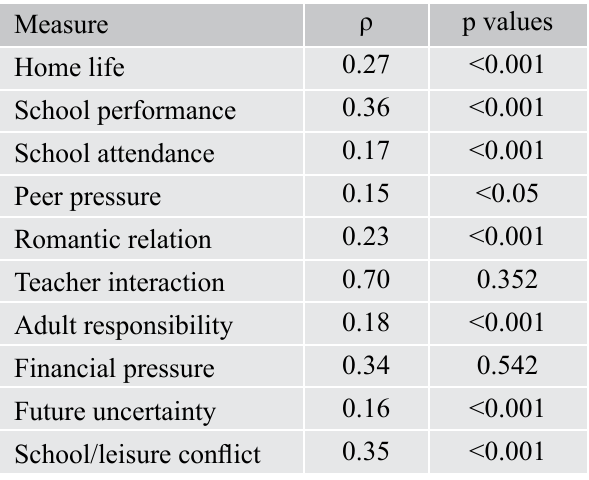
Table III: Spearman correlation of stress and